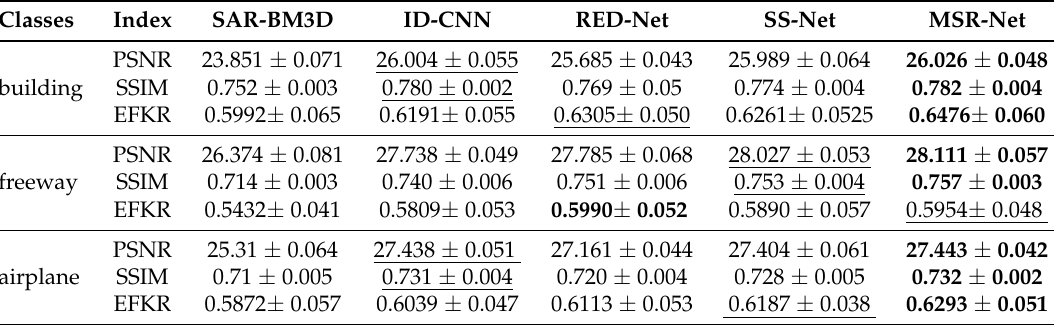
Table 3. The PSNR, SSIM, and EFKR of test set with the noise level L = 8.